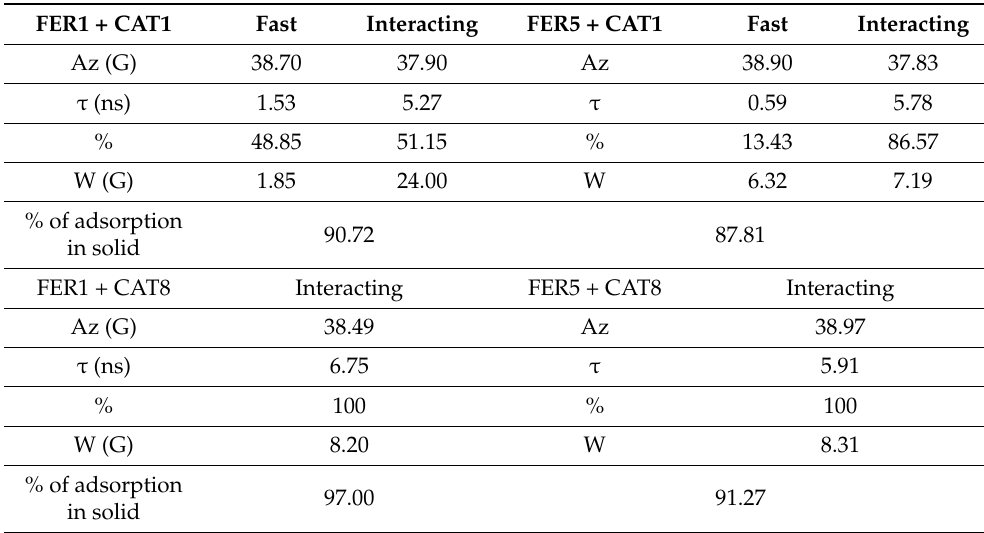
Table 8. Main parameters calculated by the spectral simulation for CAT1 and CAT8 probes adsorbed in solid